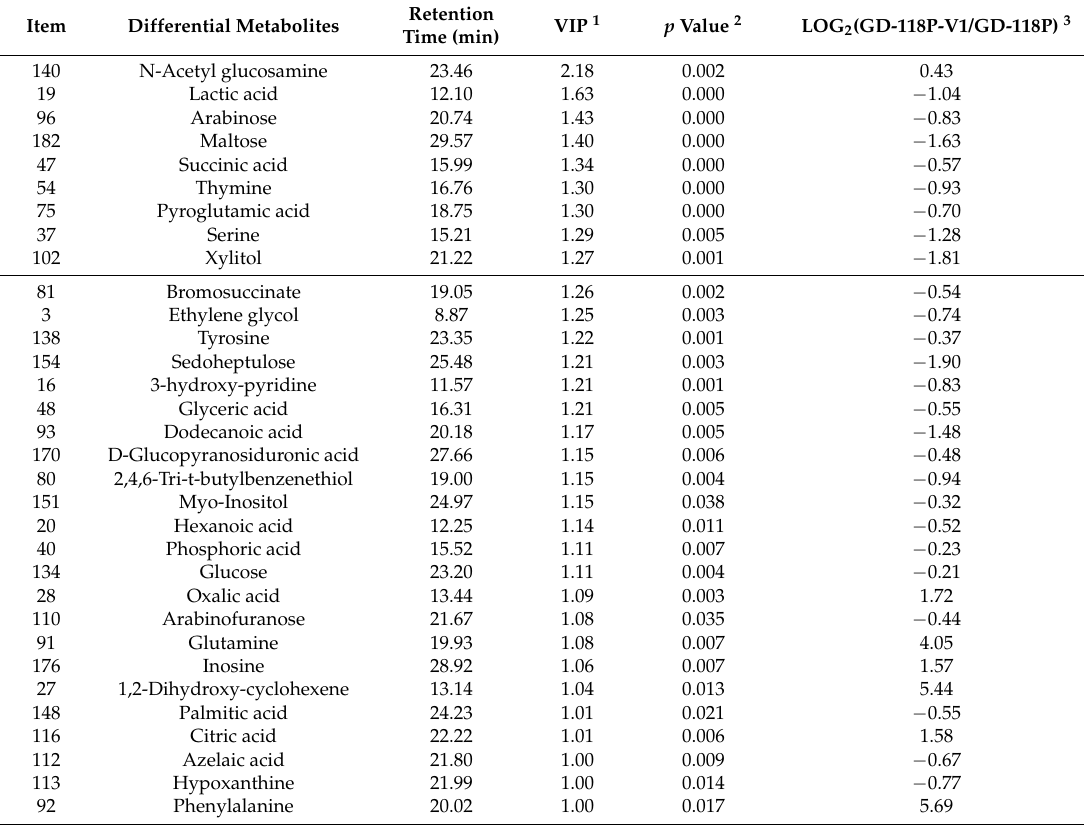
Table 1. The differential metabolites in virus-free and -containing isogenic strains of Rhizoctonia solani AG-1